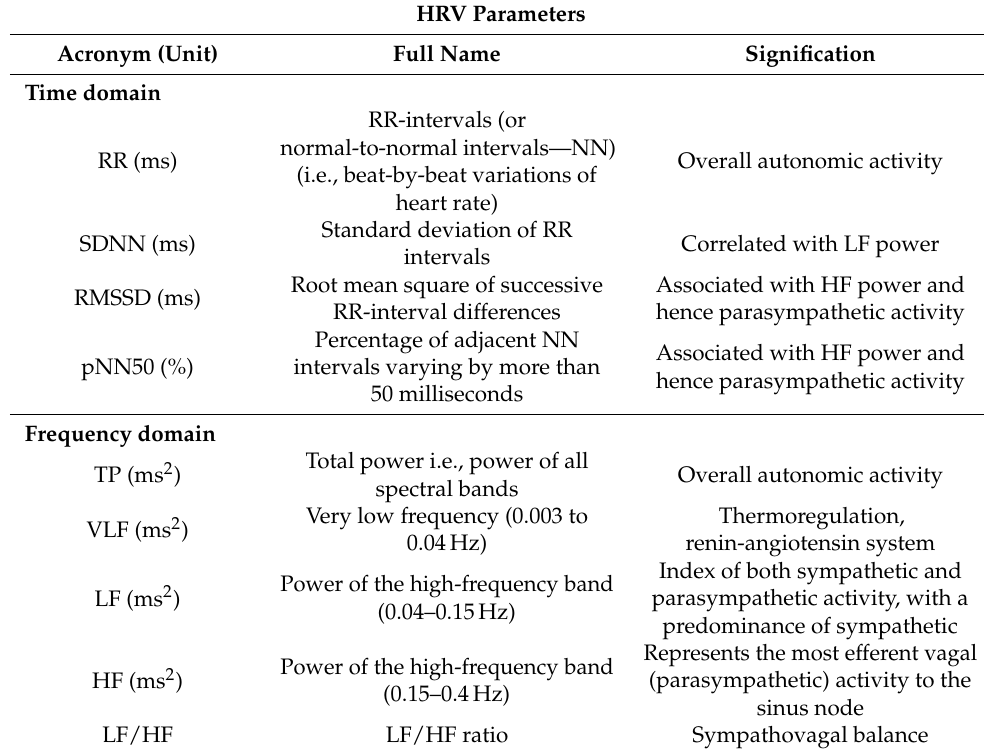
Table 1. Descriptive characteristics of HRV